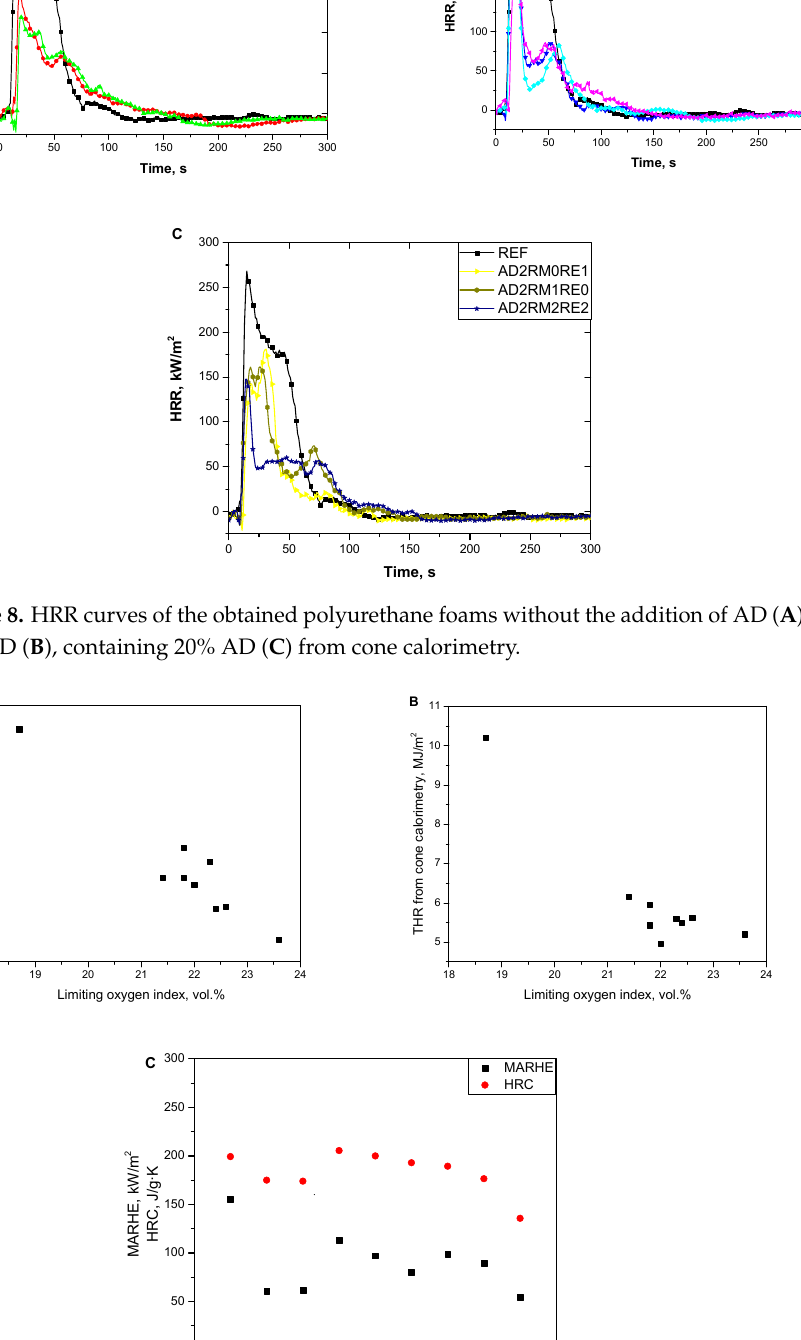
Limiting oxygen index, vol.%